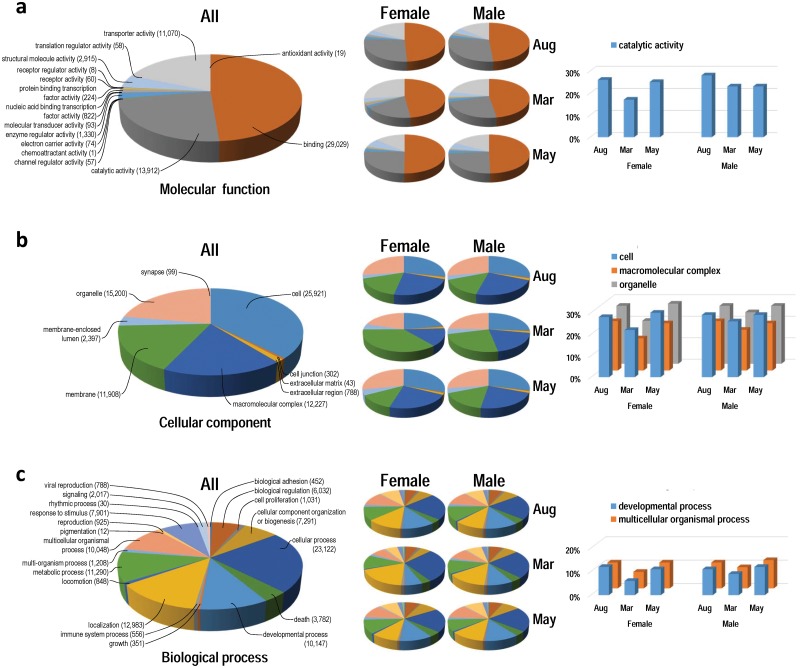
Gene ontology (GO) analysis of Atlantic cod fast skeletal muscle transcriptome annotated to UniGene cDNA reference data.Analysis was performed with Blast2GO-PRO. a) Distribution of transcripts with major category of molecular functions at level 2. b) Distribution of transcripts with major category of cellular component. c) Distribution of transcripts with major category of biological process. The larger pie charts display the combined transcript data from six libraries, whereas smaller pie charts indicate individual data for each library.